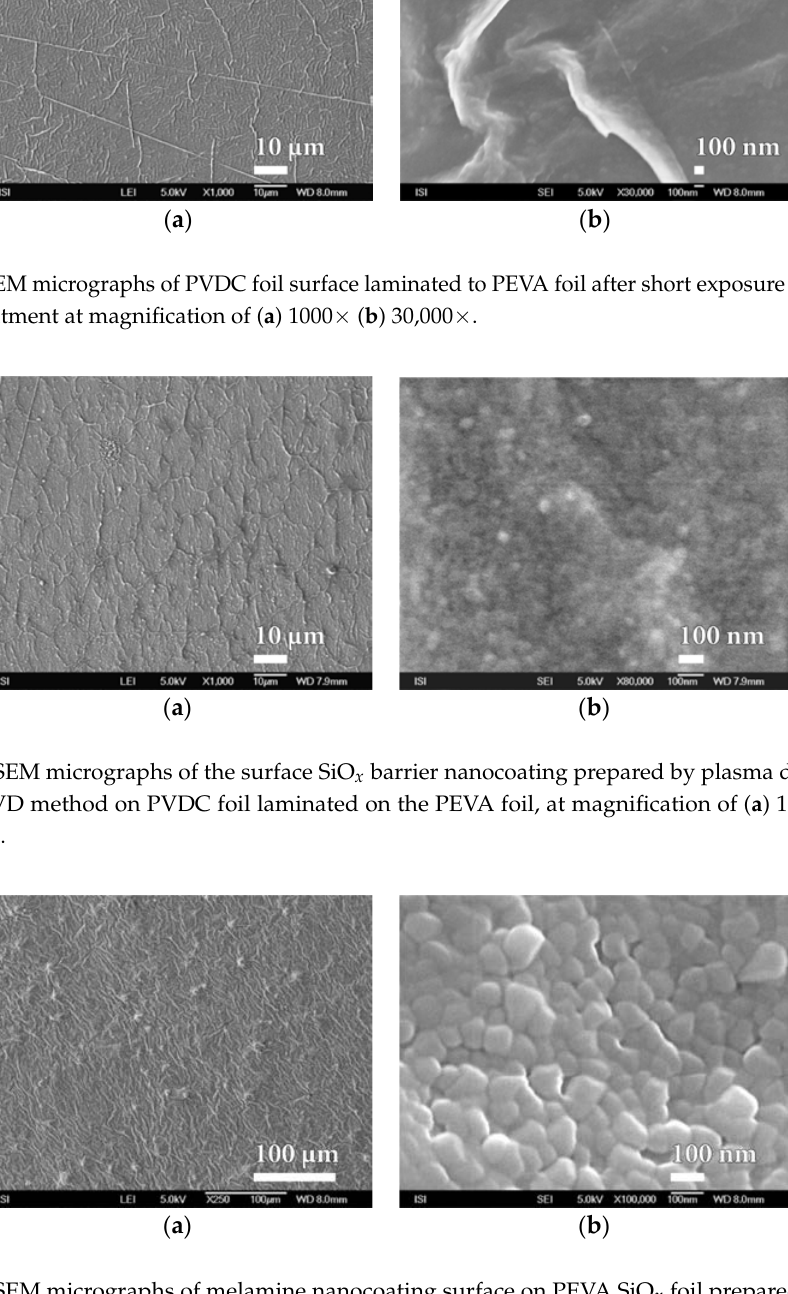
Figure 9. SEM micrographs of PVDC foil surface laminated to PEVA foil after short exposure to oxygen plasma treatment at magnification of ( a ) 1000× ( b ) 30,000×.